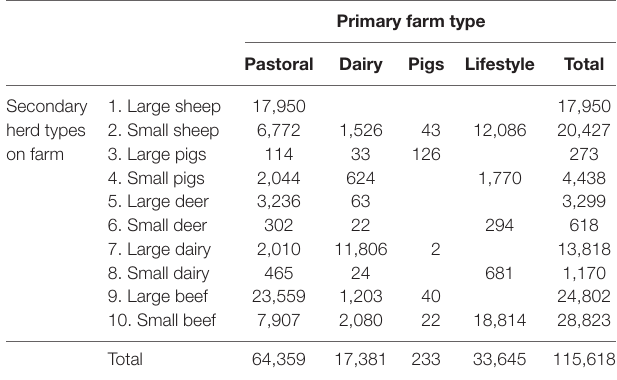
Table 1 | Counts of secondary herd types and primary farm types used to parameterize the Australian Animal Disease model.